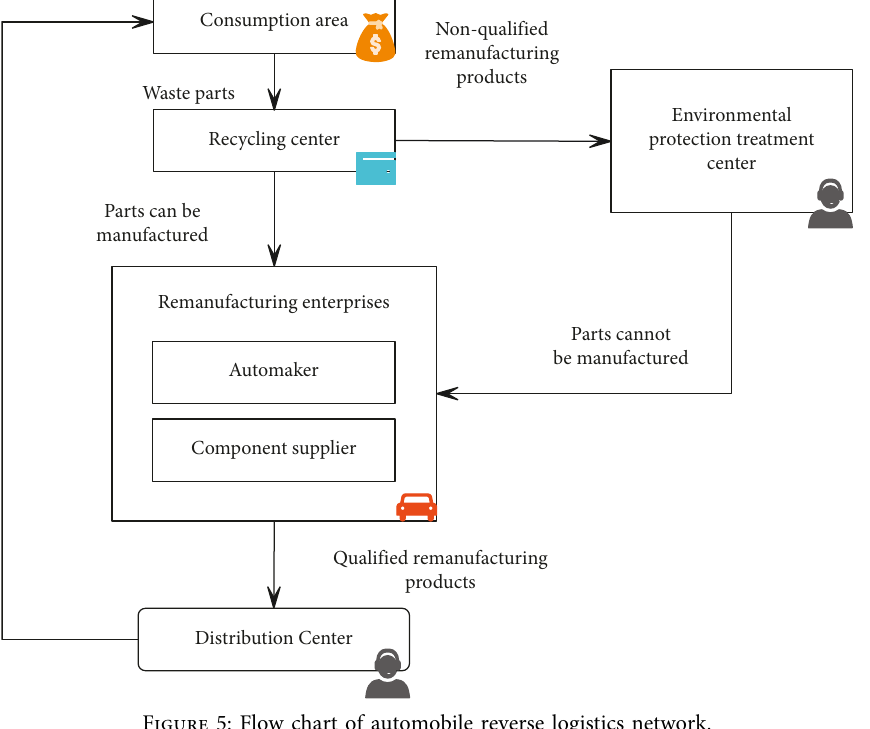
Figure 5: Flow chart of automobile reverse logistics network.